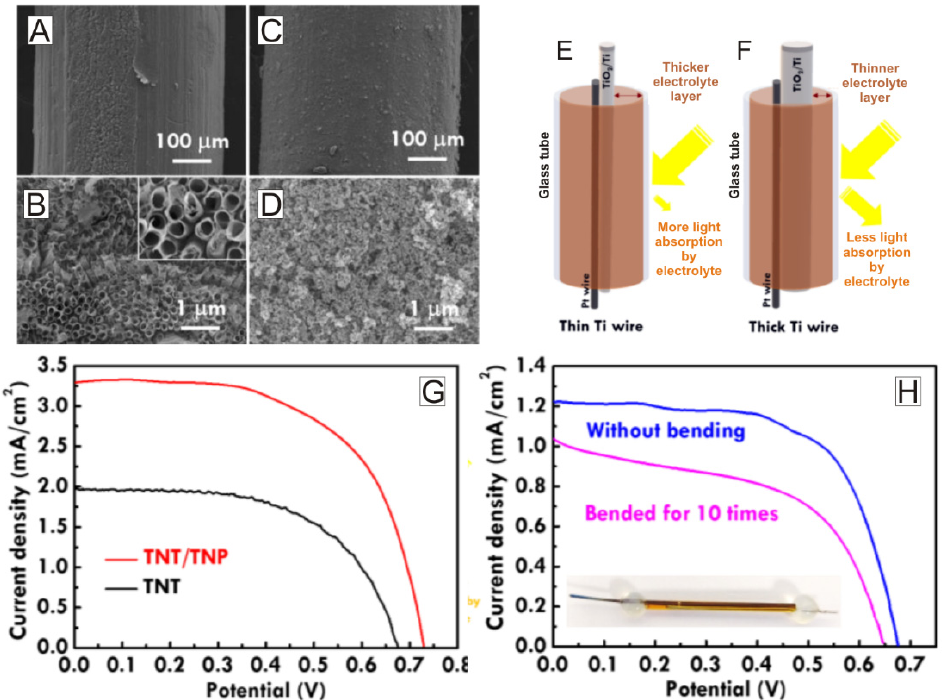
Figure 2. The SEM images of TNT ( A , B ) and TNP/TNT ( C , D ). Illustration of FDSSC with different diameters of Ti wires of the same size as a glass tube ( E , F ). LSV curves for the FDSSC with the TNT and TNP/TNT photoanodes assembled using glass tube ( G ) and plastic tube ( H ) without bending and with bending repeated ten times. Figure adapted from [17] .